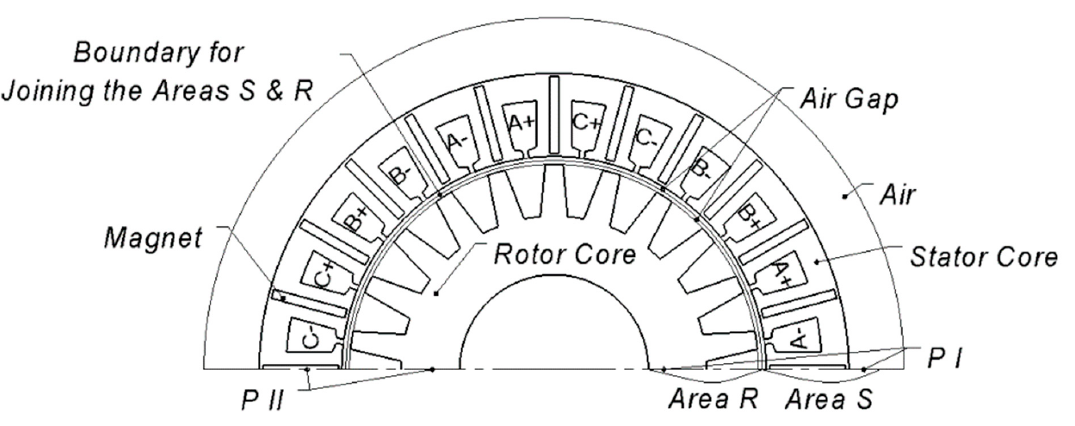
Figure 2. Calculation area.